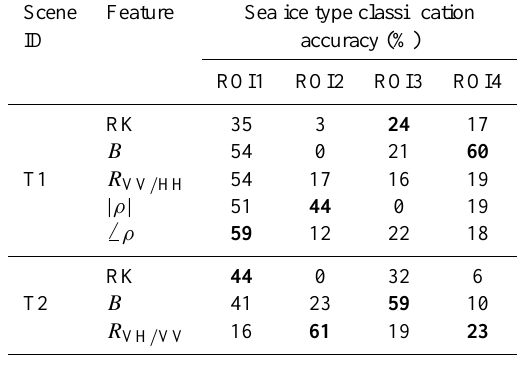
Table 5. Classification accuracy of individual polarimetric features in the two TerraSAR-X scenes derived from MAP classification. The best result for each ROI in each scene is highlighted in bold.